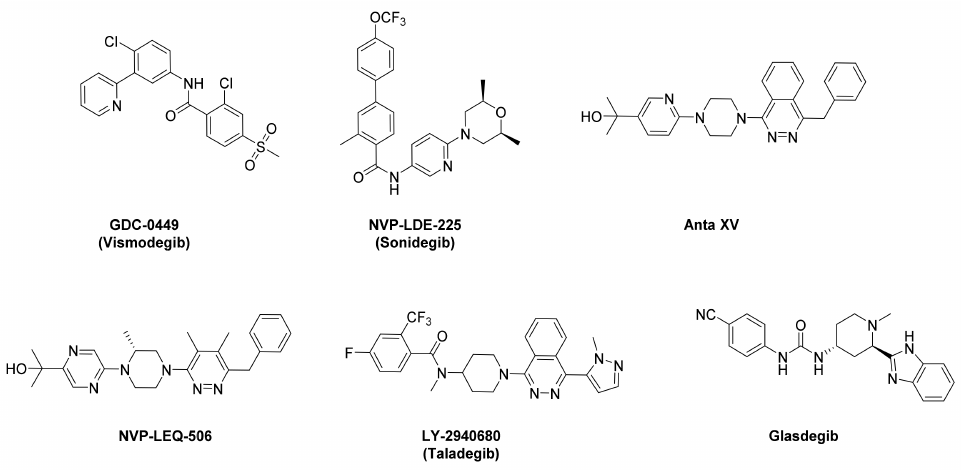
Figure 1. Chemical structure of SMO antagonists approved by the FDA or in clinical phase